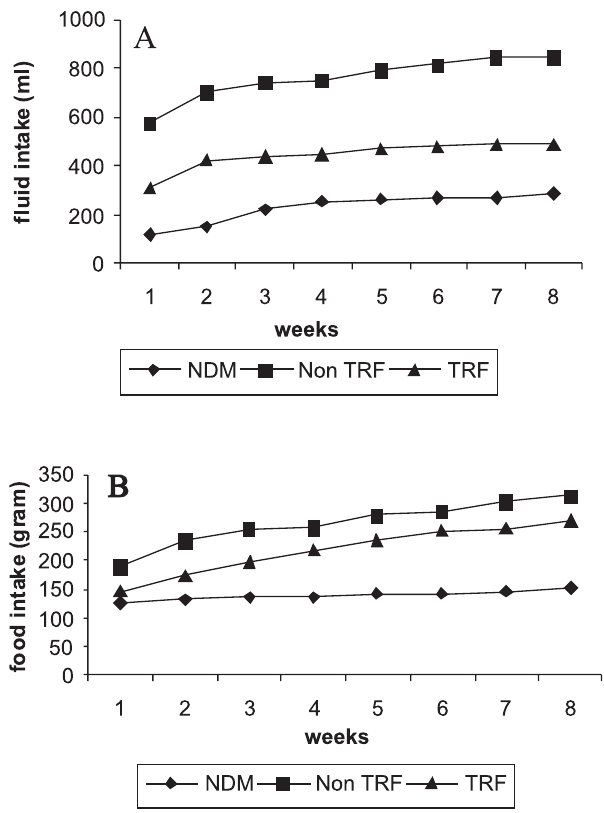
Figure 1 - Mean weekly water (A) and food (B) intakes in different groups of rats. Food and water intakes were calculated per cage (two animals in a cage), so statistical analysis was not possible Table 1 - Plasma glucose, HbA1c and lipid profiles in NDM, non-TRF and TRF groups following eight weeks of study Parameter